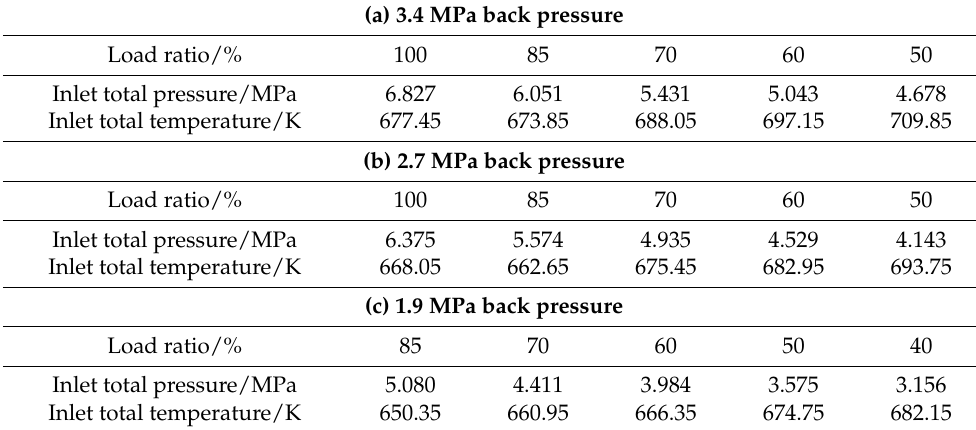
Table 1. Boundary conditions for each calculation case.